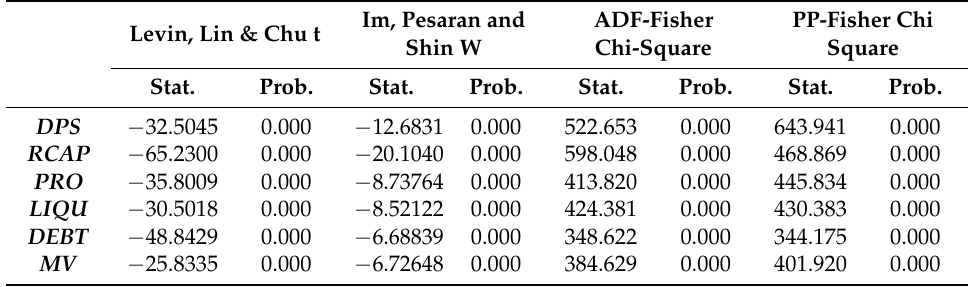
Table 4. Results of Unit Root Tests Applied to the